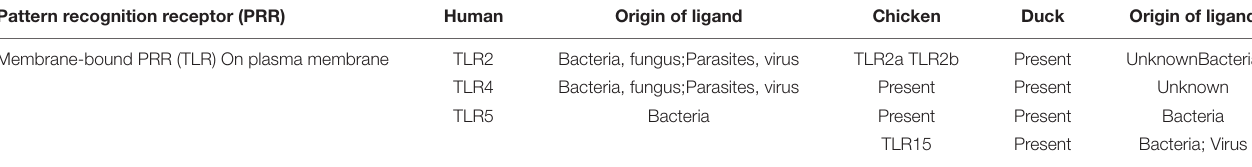
TABLE 2 | Comparison of the toll-like receptors (TLR) between human and birds. Pattern recognition receptor